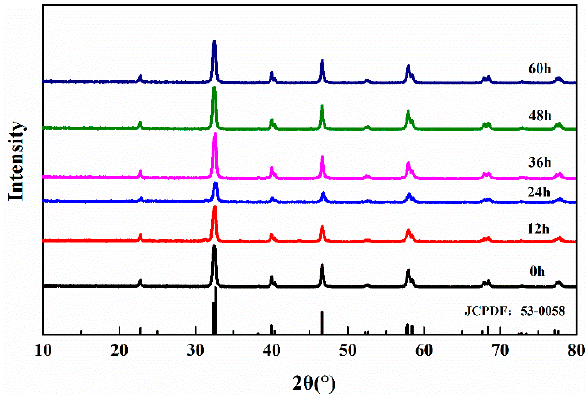
Figure 5. XRD patterns of La 0.8 Sr 0.2 MnO 3 powders under different ball milling durations.